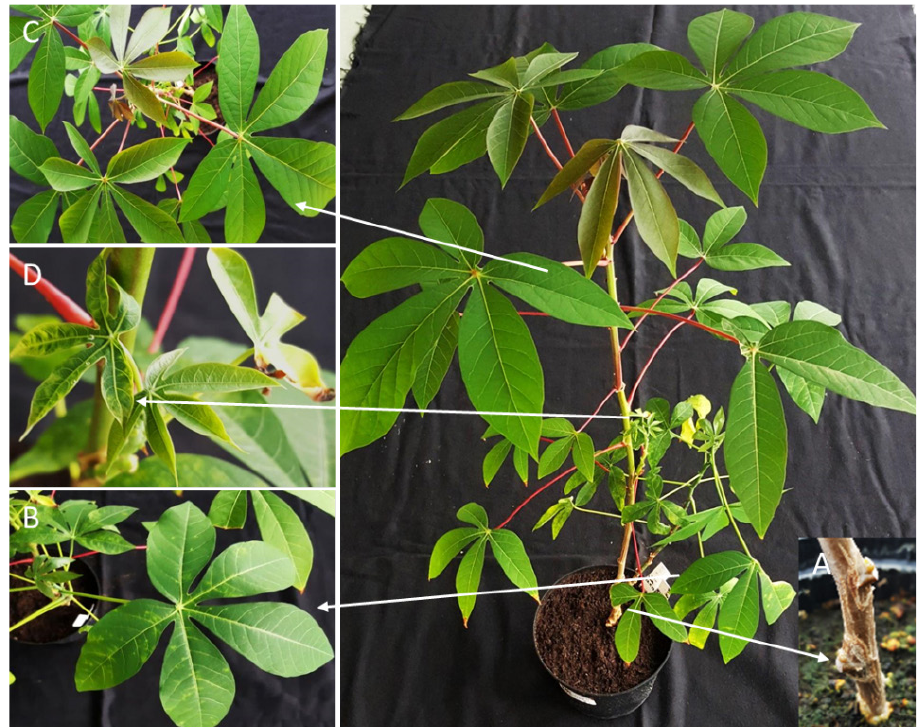
Figure 2. Virus movement through a resistant cassava DSC 167. A TMS 96/0304-DSC 167 chimeric plant was infected with CBSV-Mo83 by inserting 2 buds onto the TMS 96/0304 rootstock ( A ); typical CBSV symptoms developed on the sensitive TMS 96/0304 12 dag ( B ). Leaves developing on the branch of the resistant DSC 167 remained symptomless ( C ), while leaves of the TMS 96/0304 scion grafted into the DSC 167 branch showed distinct CBSV symptoms, proving virus translocation through DSC 167 ( D ).